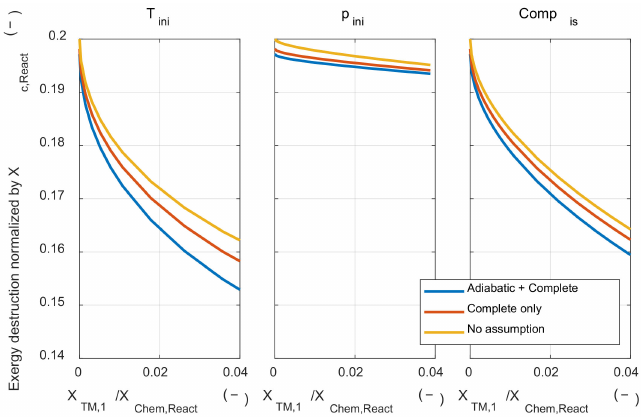
Figure A1. The exergy destruction under various initial thermodynamic states and relaxed major assumptions